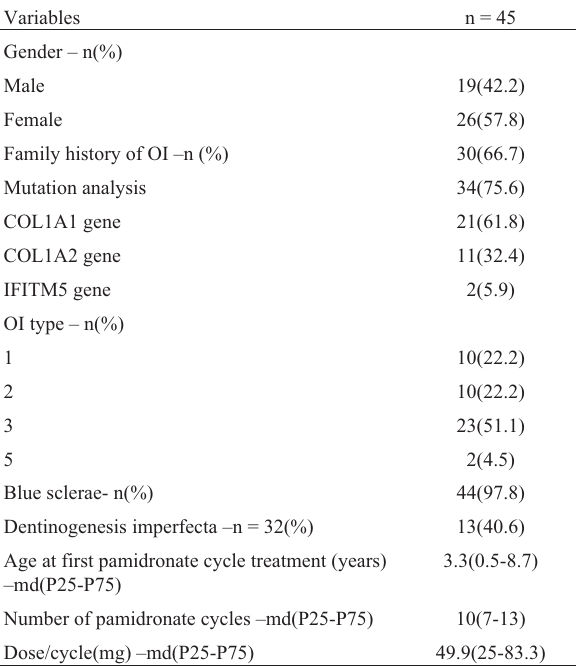
Table 1 - Clinical data of the